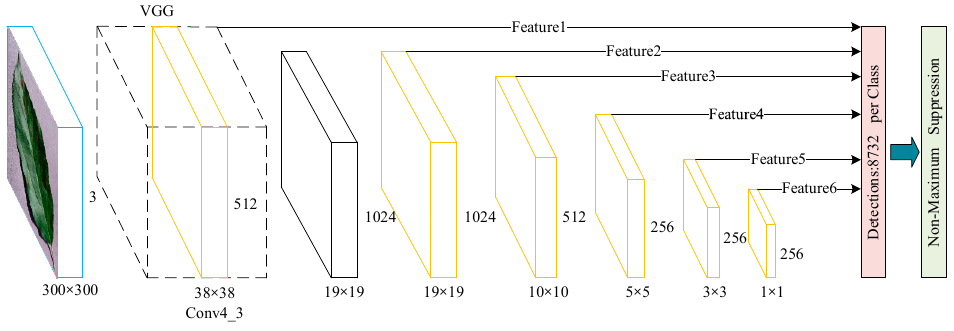
Figure 1. SSD backbone network structure.